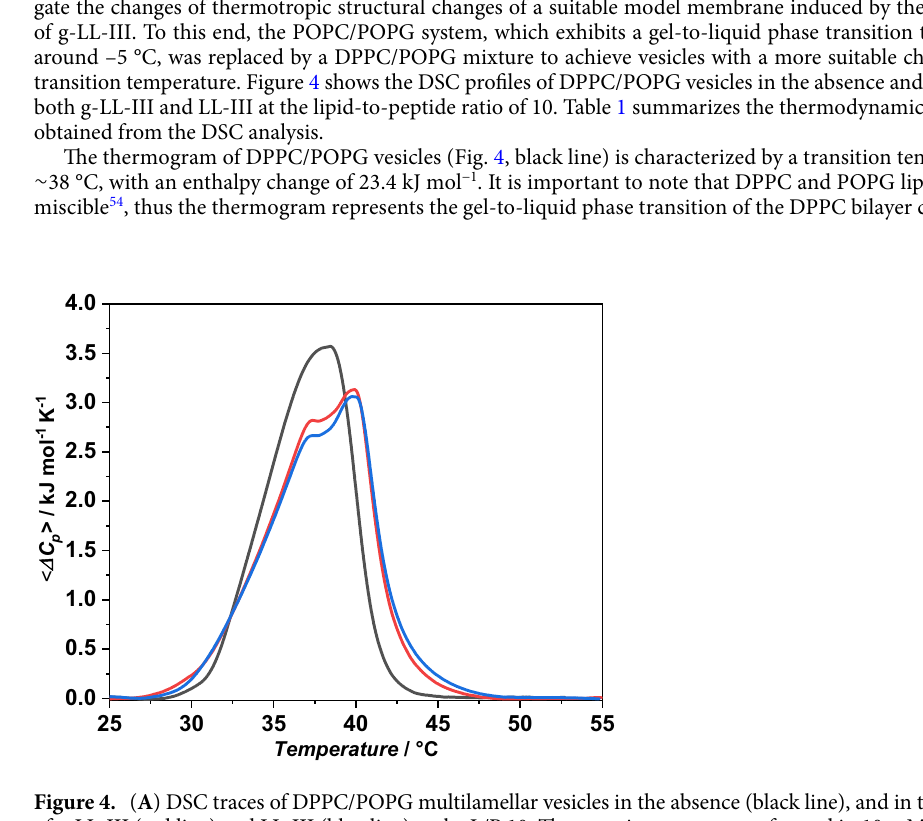
Figure 4. ( A ) DSC traces of DPPC/POPG multilamellar vesicles in the absence (black line), and in the presence of g-LL-III (red line) and LL-III (blue line) at the L/P 10. The experiments were performed in 10 mM phosphate buffer, pH 7.4.